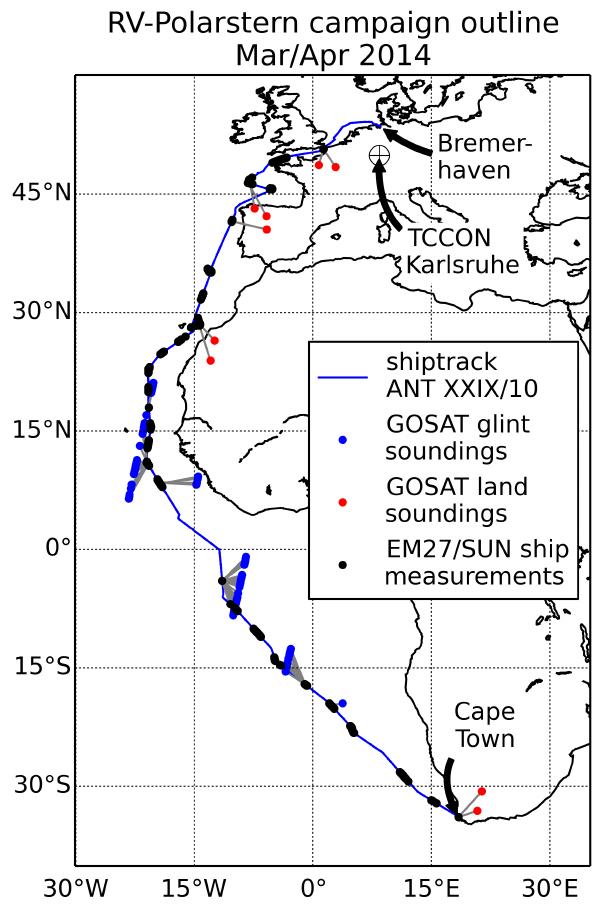
Figure 1. The ship track of the ANT XXIX/10 RV Polarstern cruise (blue line). Valid data are marked black. GOSAT-soundings that co- incide with ship-based measurements within ± 4h and 5 ◦ (lat, lon) are marked in blue (ocean) and red (land) and interconnected (gray